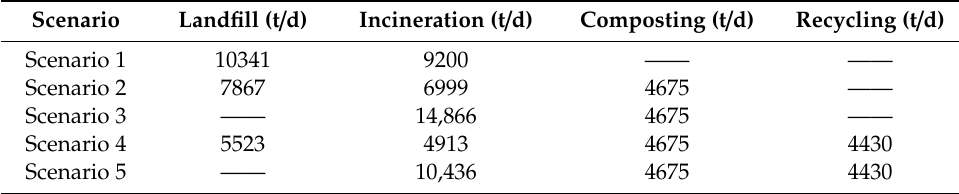
Table 3. MSW disposal quantity by di ff erent treatment way in five scenarios.